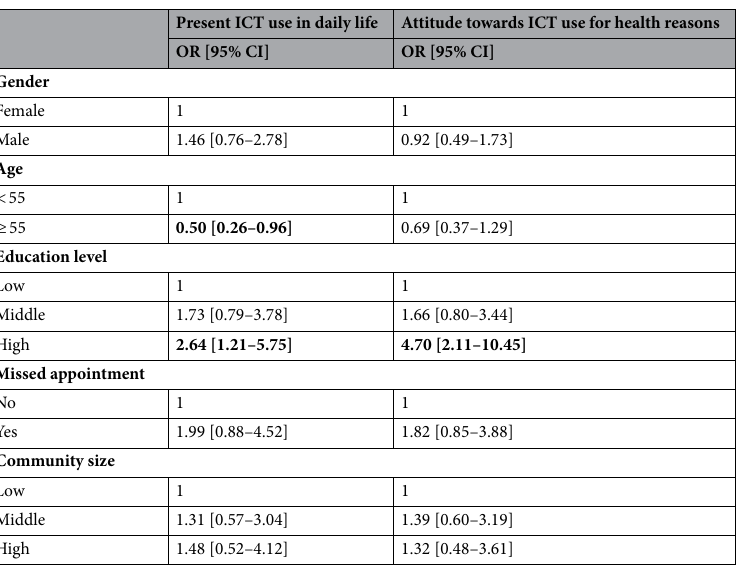
Table 2. Association between gender, age, education level, missed appointments, community size, modern ICT use in daily life and the attitude towards ICT use for health reasons. Bold values are statistcally significant for p<0.05 values.